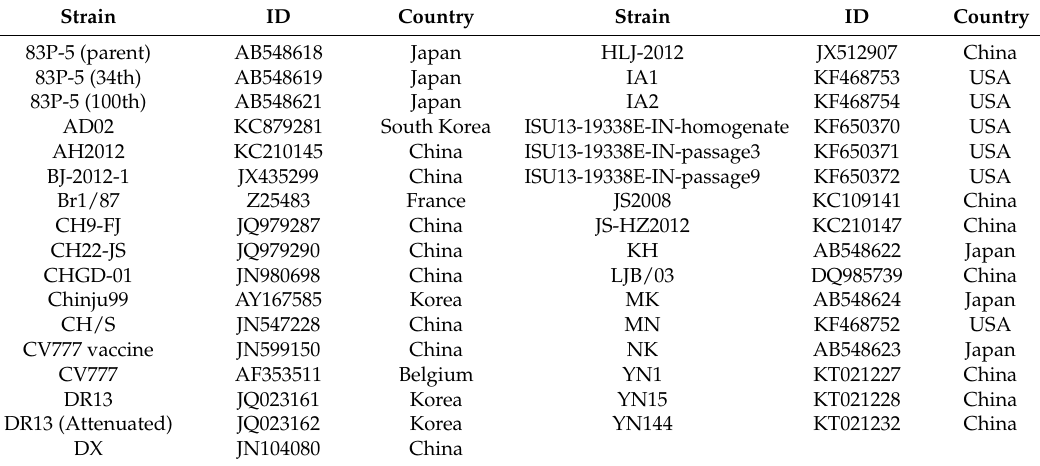
Table 1. Reference strains of porcine epidemic diarrhea virus (PEDV) used in this study. Strain ID Country Strain